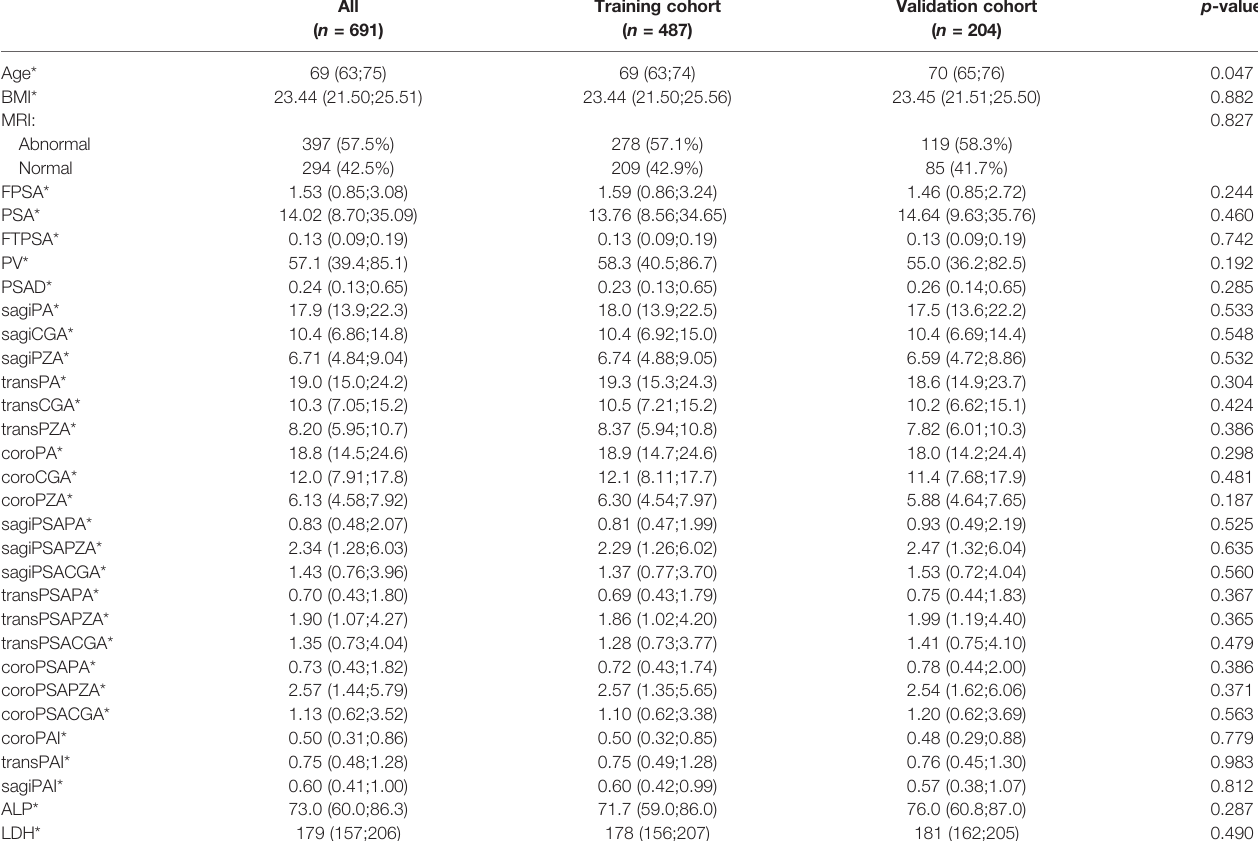
TABLE 2 | Clinical characteristics of patients in training cohort and validation